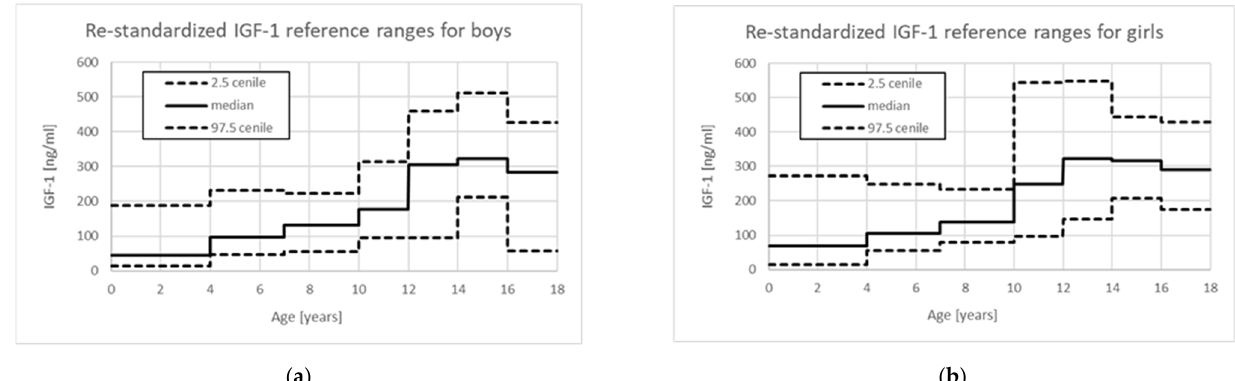
Figure 1. Centile charts based on Pediatric reference ranges for re-standardized IGF-1 assays provided for IMMULITE 2000 Immunoassay System [67]: ( a ) for boys; ( b ) for girls.